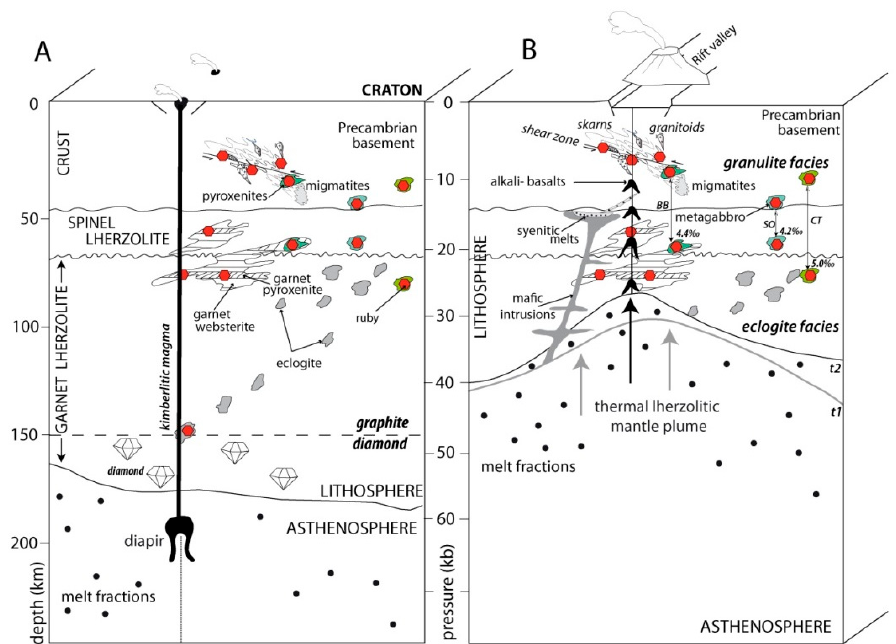
Figure 29. Schematic genetic models for gem corundum related to kimberlite ( A ) and alkali basalt ( B ) environments, modified from [178–180]. The drawings show the different types of corundum occurrences hosted in Precambrian basements in the crust, and lherzolites in the lithosphere. Selected ruby occurrences are indicated (with their corresponding δ 18 O composition, in ‰) including the Beni Bousera (BB) garnet clinopyroxenite, the Soamiakatra (SO) garnet metagabbro and -clinopyroxenite, and the Chanthaburi-Trat (CT) pyroxene inclusion in ruby, with their retrograde metamorphic location in the granulite facies. Panel ( B ) shows ruby deposits associated with alkali basalt in continental extension domains characterized by thermal anomalies linked to mantle plumes and rift valley fracturing and volcanism in the upper part of the crust. t1 and t2 are two successive ascent stages of the alkali basalt magmatism.